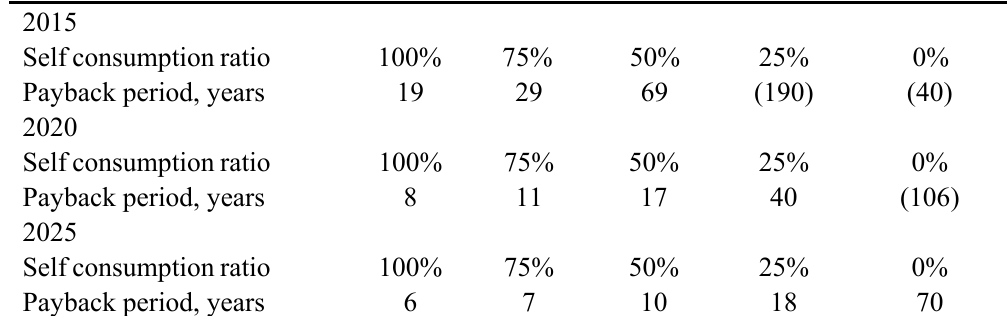
Figure 7. Residential rooftop payback periods, number of years, 2015–2025. Table 1. UK average payback period for unsupported residential solar, according to self-consumption ratio, 2015–2025.